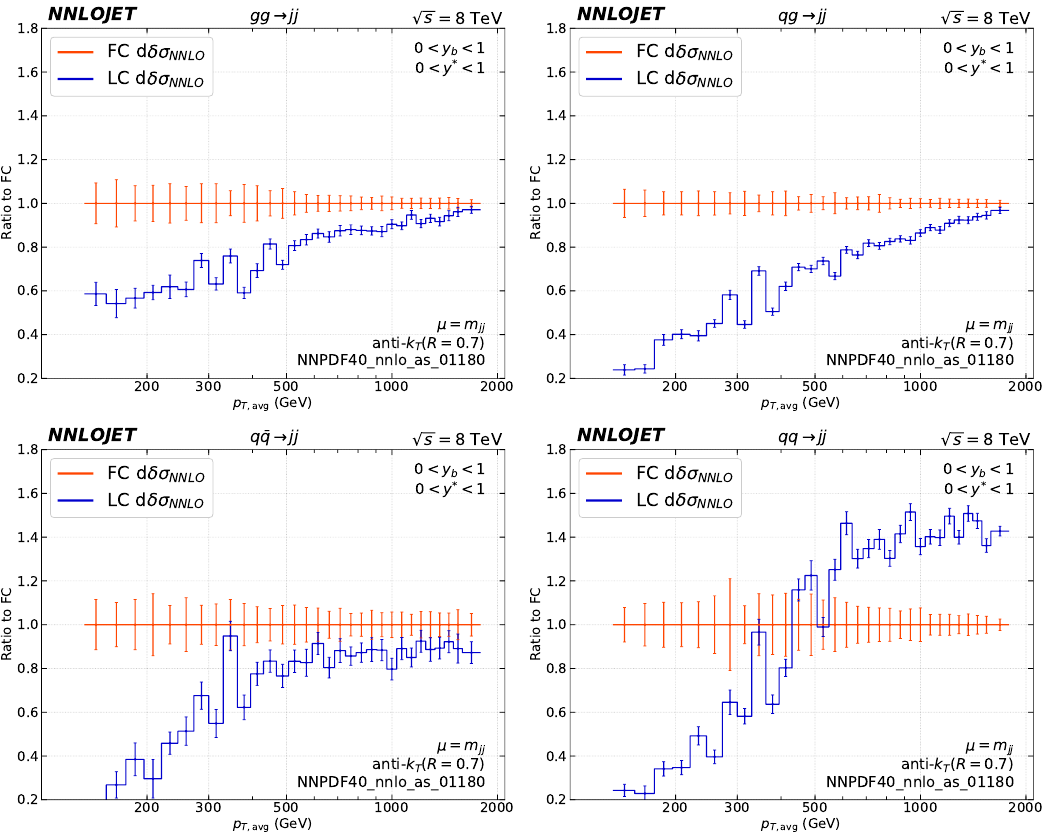
Figure 16 . NNLO coefficient d δσ NNLO at LC (blue) and FC (red) for the gluon-gluon, quark-gluon, quark-antiquark and quark-quark initiated dijet cross section in the ( y b , y ∗ ) = ([0; 1] , [0; 1]) bin. Ratios are evaluated at the central scale and error bars represent numerical integration errors